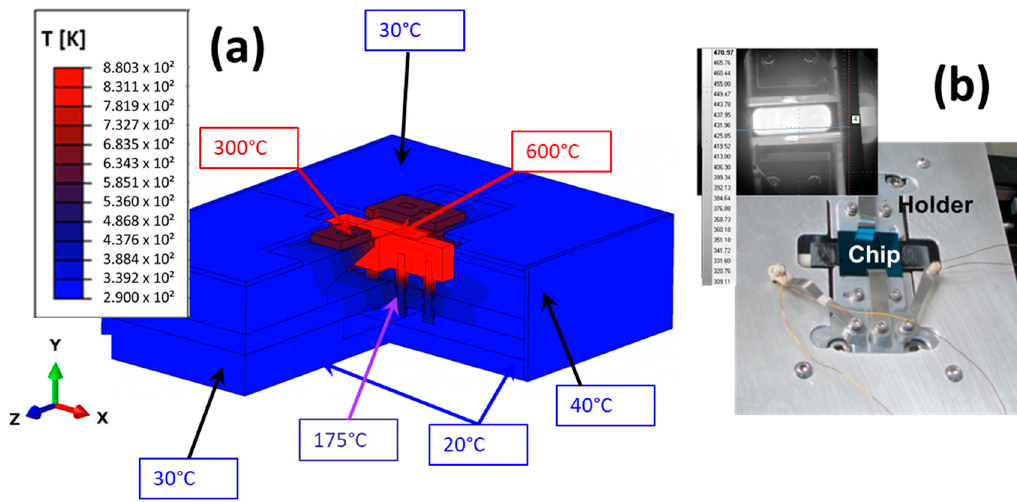
Figure 3. ( a ) Buildup of the device in the FEM modeling program and FE calculation of the temperature distribution. ( b ) Image of the heater with a dummy chip and the thermography image of the heater in operation. Please note that Si is mainly transparent for IR and therefore the heater is imaged by